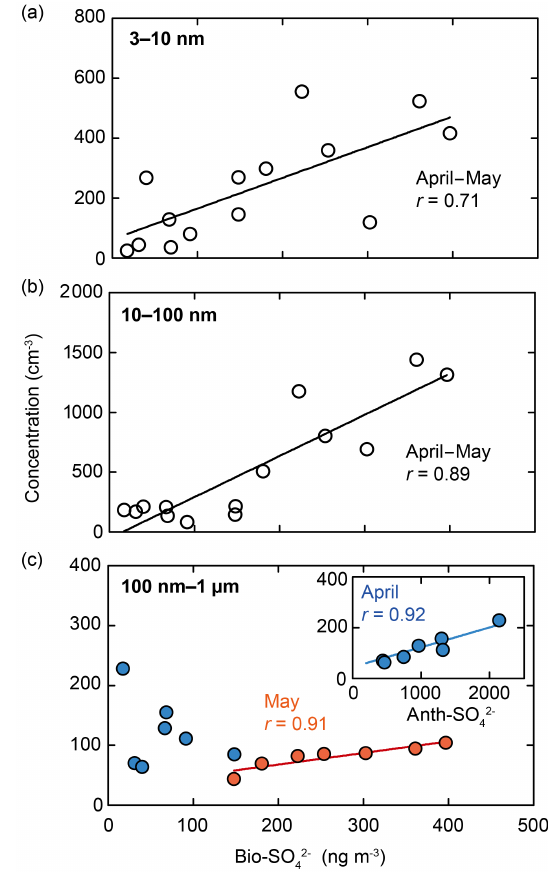
Figure 6. Relationships between the concentration of biogenic (bio) SO 2 − and the concentrations of particles of various sizes in 4 April and May. (a) Particles 3–10nm, (b) particles 10–100nm, and (c) particles 100nm–1µm. The black solid lines in (a, b) indicate the best fit between biogenic SO 2 − and the particle concentration 4 during April and May 2015. Blue and red circles in (c) indicate data obtained in April (Arctic haze period) and May (phytoplank- ton bloom period), respectively. The red solid line in (c) indicates the best fit between biogenic SO 2 − and particle concentration in 4 May 2015, and the blue solid line in the inset of (c) indicates the best fit between anthropogenic (anth) SO 2 − and particle concentra- 4 tion in April